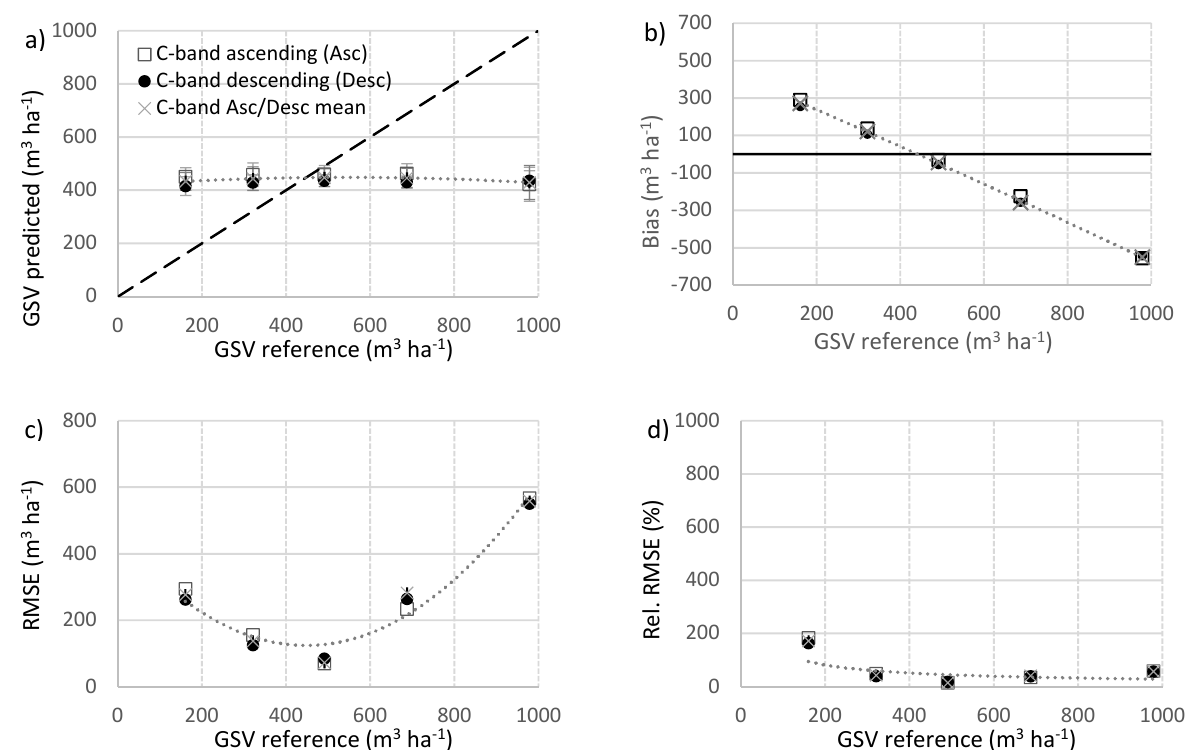
Figure 5. GSV retrieval metrics for 10 × 10 km grid cells for single polarization C-band models. Panels ( a – d ) show the same information as in Figure 4.